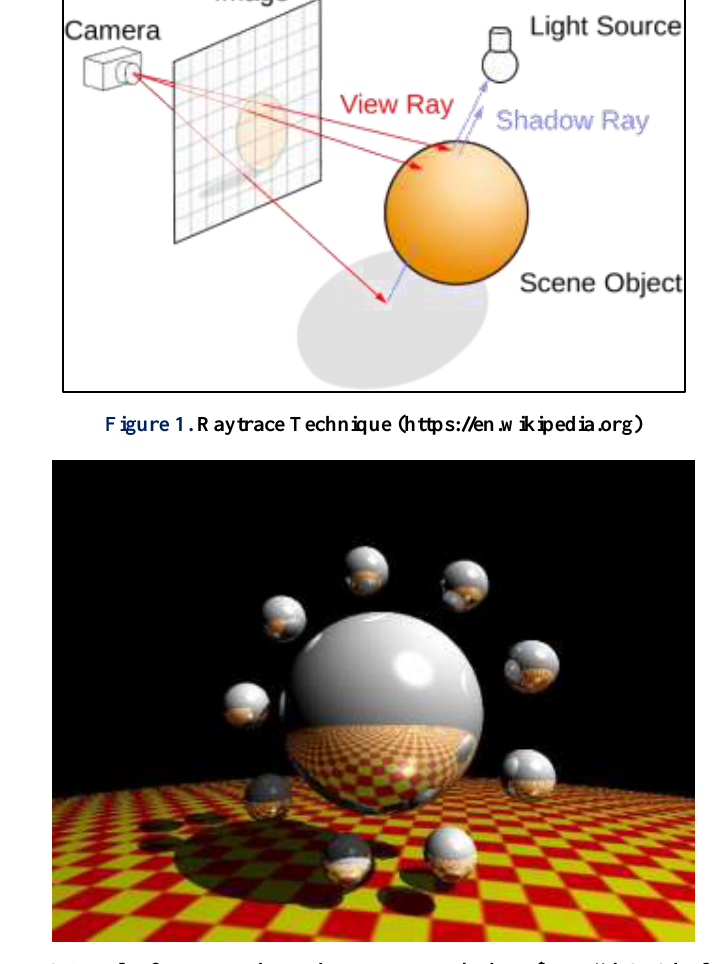
Figure 2. Result of create an image by raytrace technique